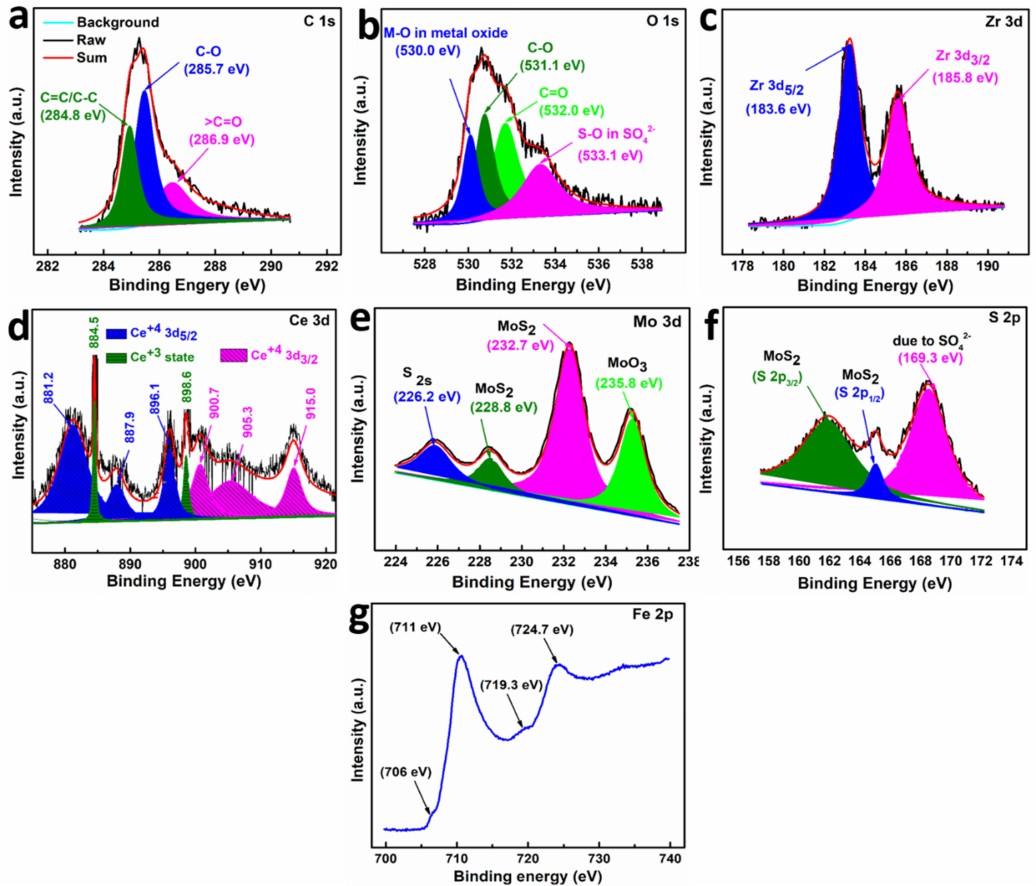
Figure 12. X-ray photoelectron spectroscopy (XPS) spectra of the worn surface lubricated with ZCO-2@rGO@MoS 2 nanocomposite: ( a ) C 1s, ( b ) O 1s, ( c ) Zr 3d, ( d ) Ce 3d, ( e ) Mo 3d, ( f ) S 2p, and ( g )